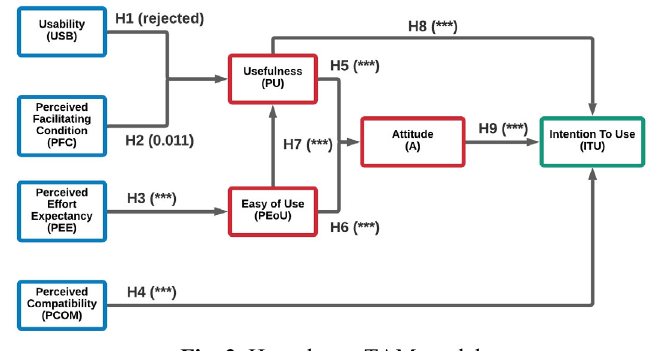
Fig. 3. Hypotheses TAM